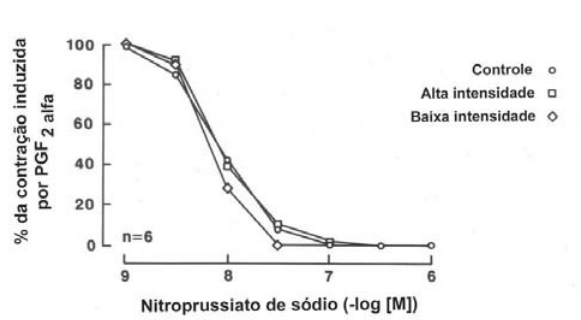
Fig. 6 - Relaxamento independente do endotélio induzido por nitroprussiato de sódio (NPS) em artérias coronárias caninas. As artérias foram expostas à baixa ou alta intensidade de energia ultra- sônica e contraídas com prostaglandina F (PGF ). Quando a 2 α 2 α contração induzida pela PGF estabilizou, as artérias foram 2 α submetidas a concentrações crescentes de NPS. Os dados estão apresentados como médias ± erro padrão médio e não se observaram diferenças estatisticamente significantes (n = 6, p>0,05)